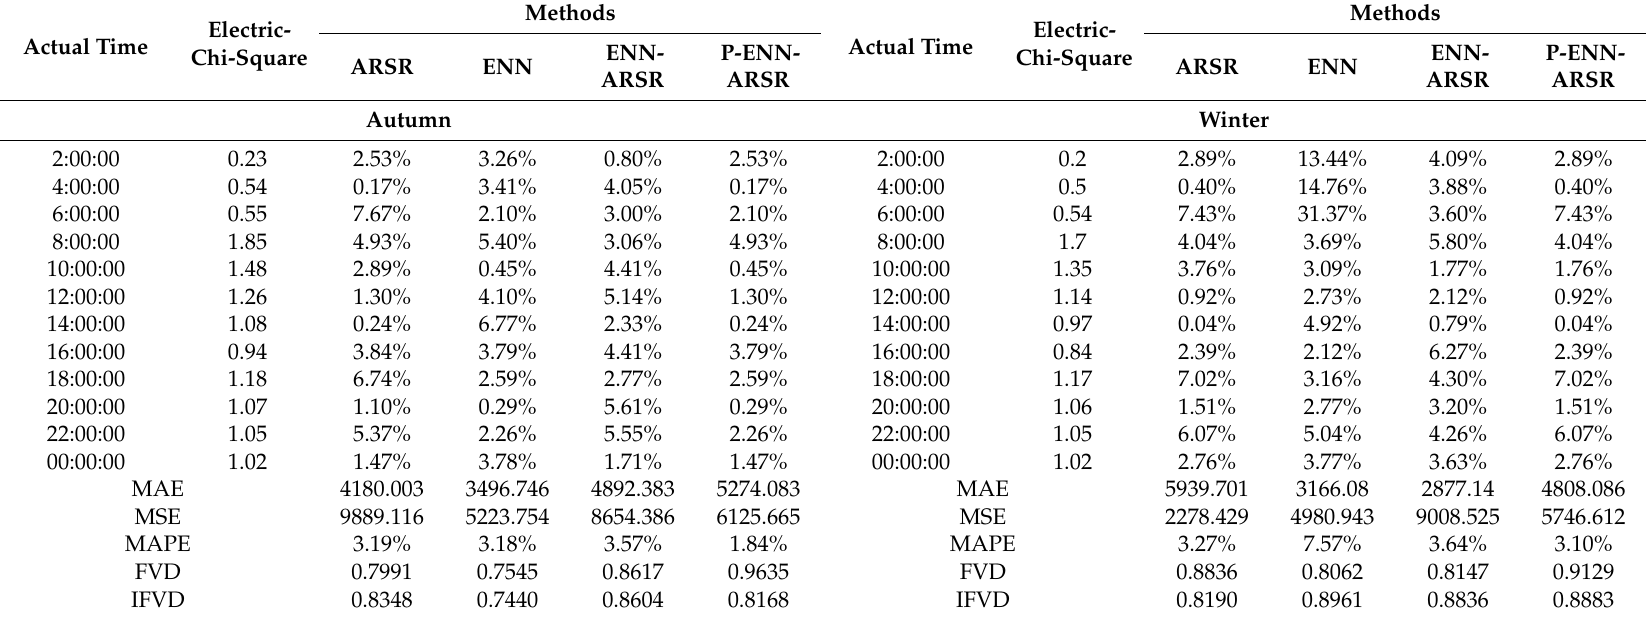
Table 6. The forecasting results of hybrid model in autumn and